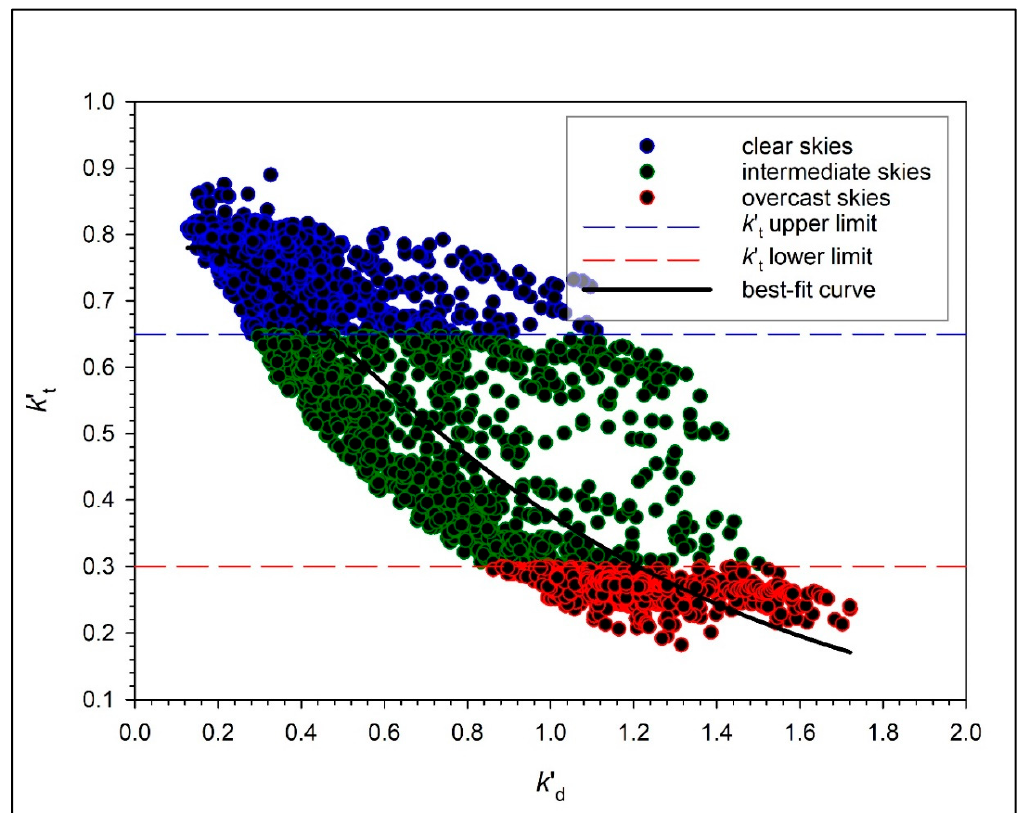
Figure 1. Graph of hourly k ’ t vs. hourly k ’ d values over one complete year for the site of Alexandroupoli; the limits of overcast, intermediate and clear skies are shown. The solid black line is the best-fit curve to the data points from Equation (20) with R 2 = 0.82.